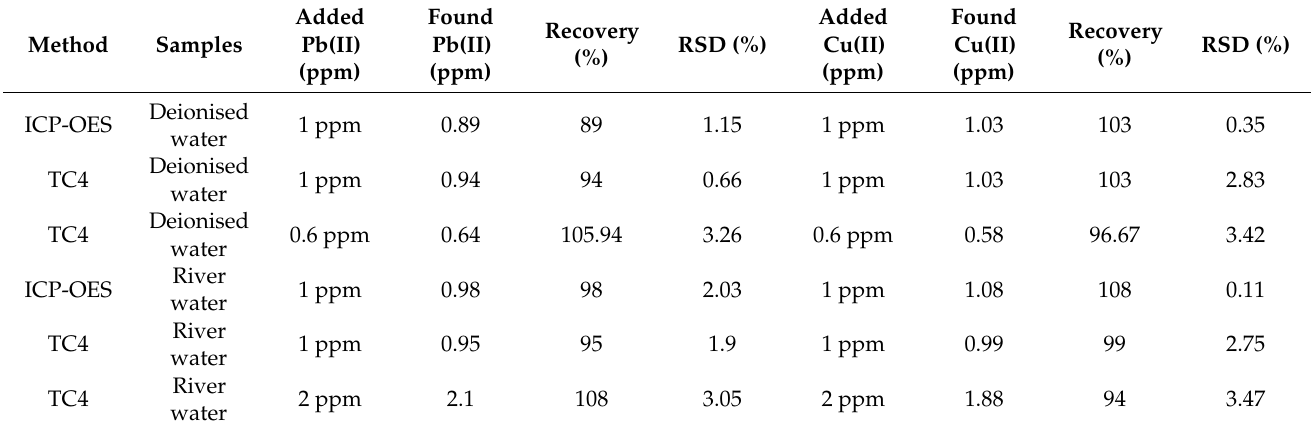
Table 5. Data validation of lead and copper ion detection in water